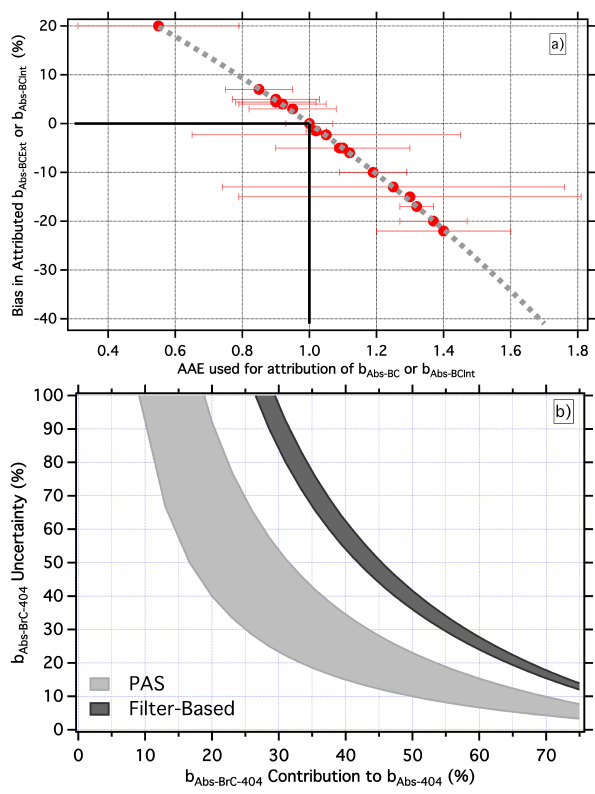
Fig. 2. (a) Theoretical uncertainties in attributed BC Ext (or BC Int ) 404nm absorption when AAE = 1, rather than another value within the possible range suggested for BC Ext or BC Int . Red data show av- erage AAE measured for particles assumed to be mostly BC ( y axis for red data forced to match black line for clarity). (b) Uncertainty in attributed BrC absorption (at 404nm) based on the uncertainties in AAE used for the absorption attribution process and the uncer- tainties in the absorption measurement